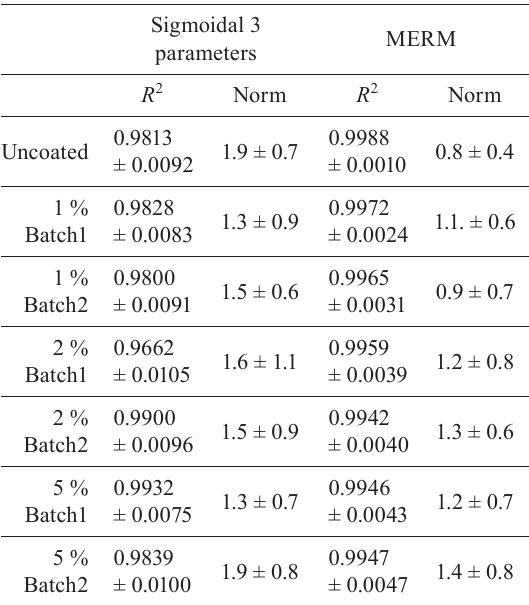
Table 2 Modelling statistics for the fitting of replicates at 60 L/min of cumulative fine particle mass- time profiles for the Rotahaler ® , to sigmoid 3 parameter, mono-exponential rise to maximum 2 parameter ( n = 5; mean ± SD